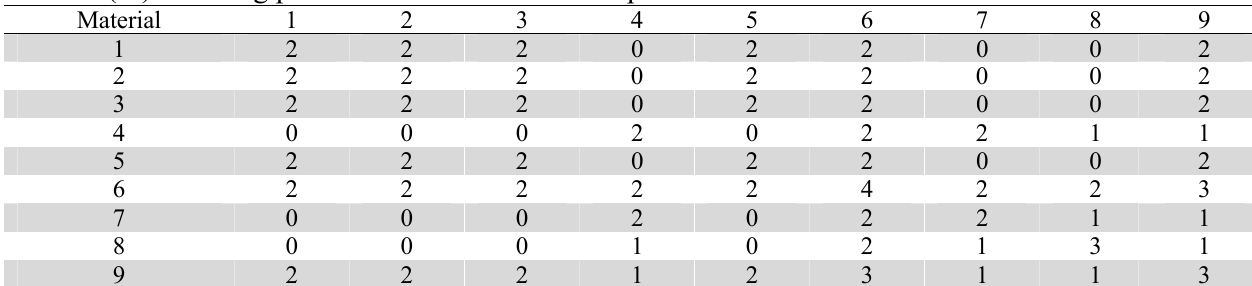
Matrix ( S 3 ) at slicing parameter θ 3 = 0.30 for example 4 Material